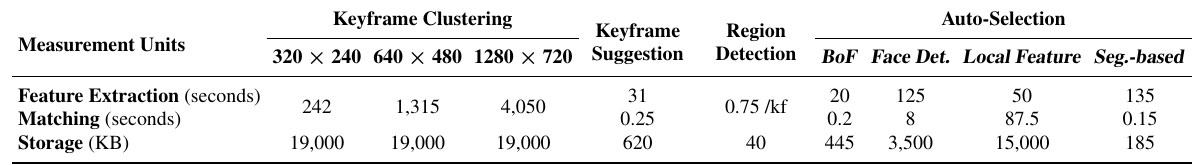
Table 2. The required run-times and storage for an average video of one